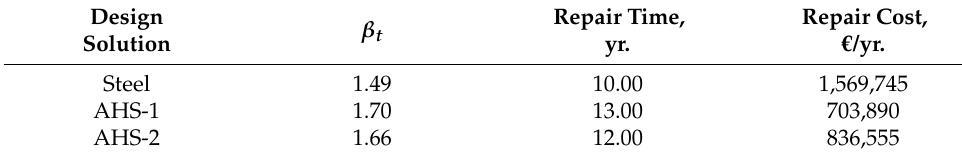
Table 3. Target beta reliability index at the first repair time and associated